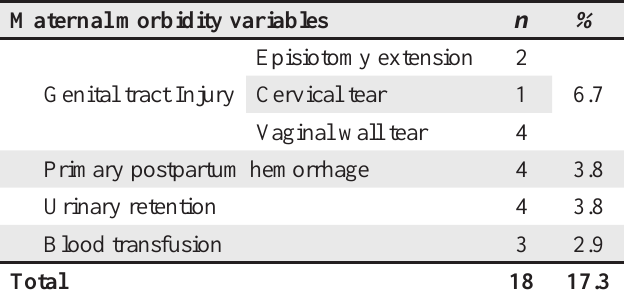
Table 1 : Maternal morbidity variables. Maternal morbidity variables